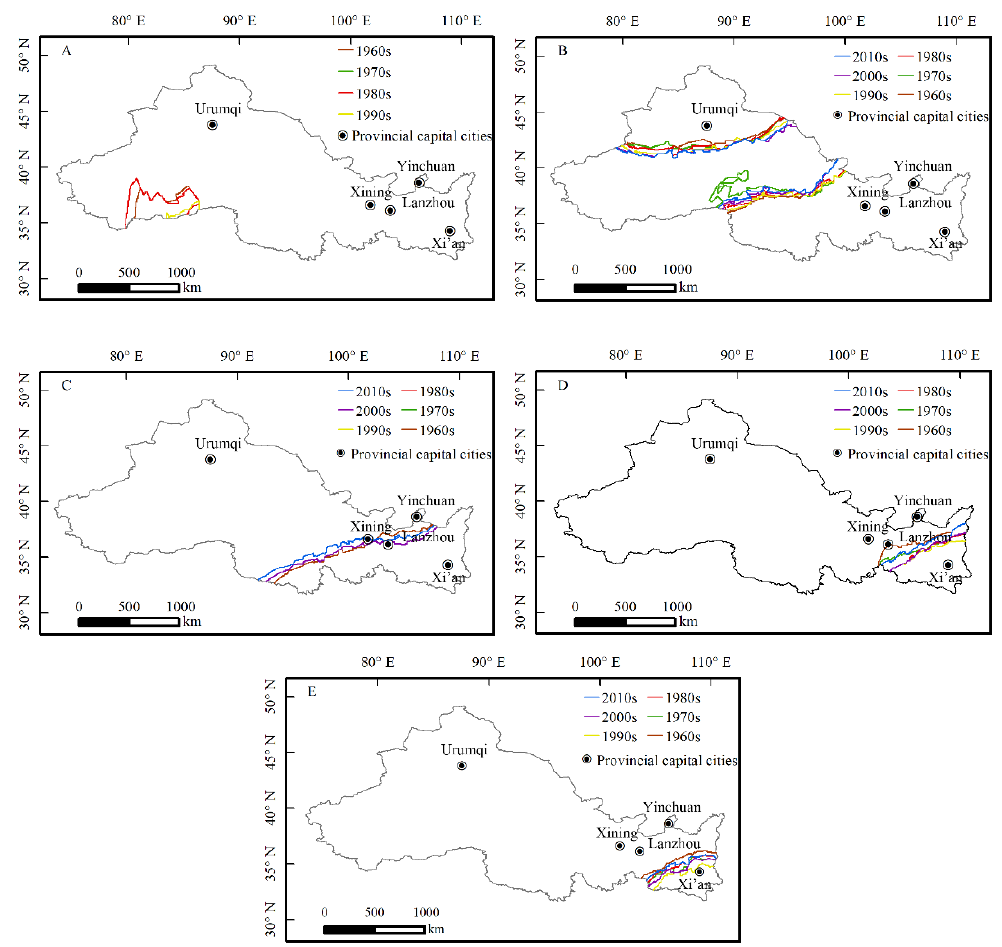
Figure 7. Interdecadal fluctuations of each dry and wet climate boundary in five provinces of Northwest China. A: 0.03 boundary B: 0.2 boundary C: 0.5 boundary D: 0.75 boundary E: 1 boundary.